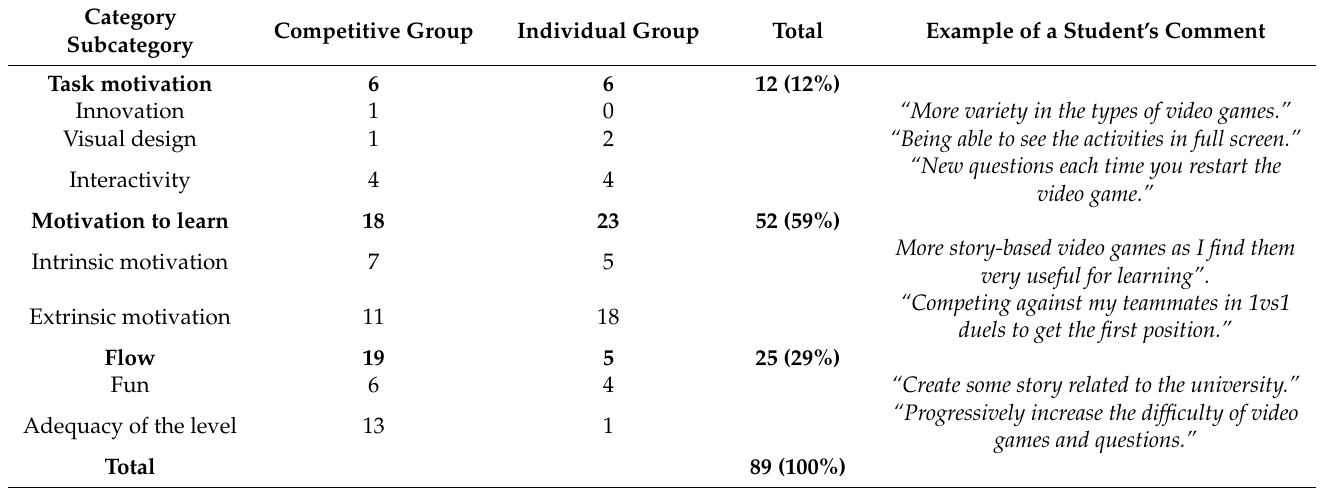
Table 5. Question 2. Comparison between competitive, individual gamifications and comment